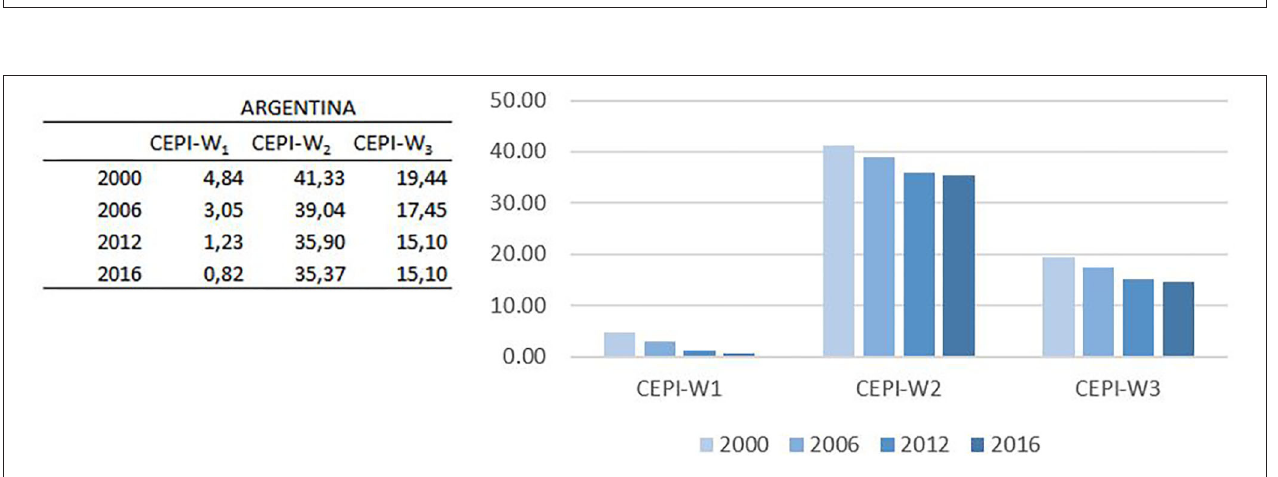
FIGURE 3 | Energy indicators (normalized)—Argentina (2000, 2006, 2012, 2016).